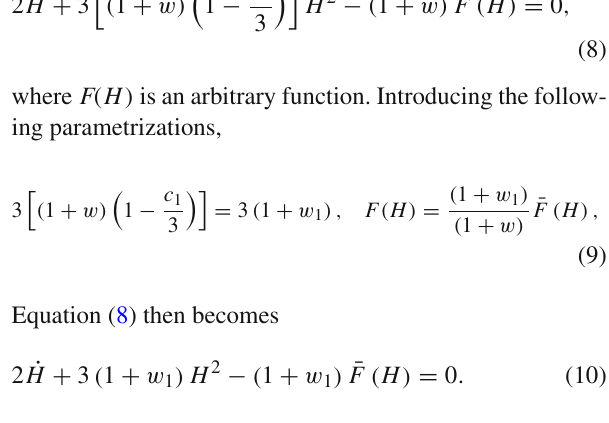
(cid:8) 1.Thebehaviour with λ B 2 2